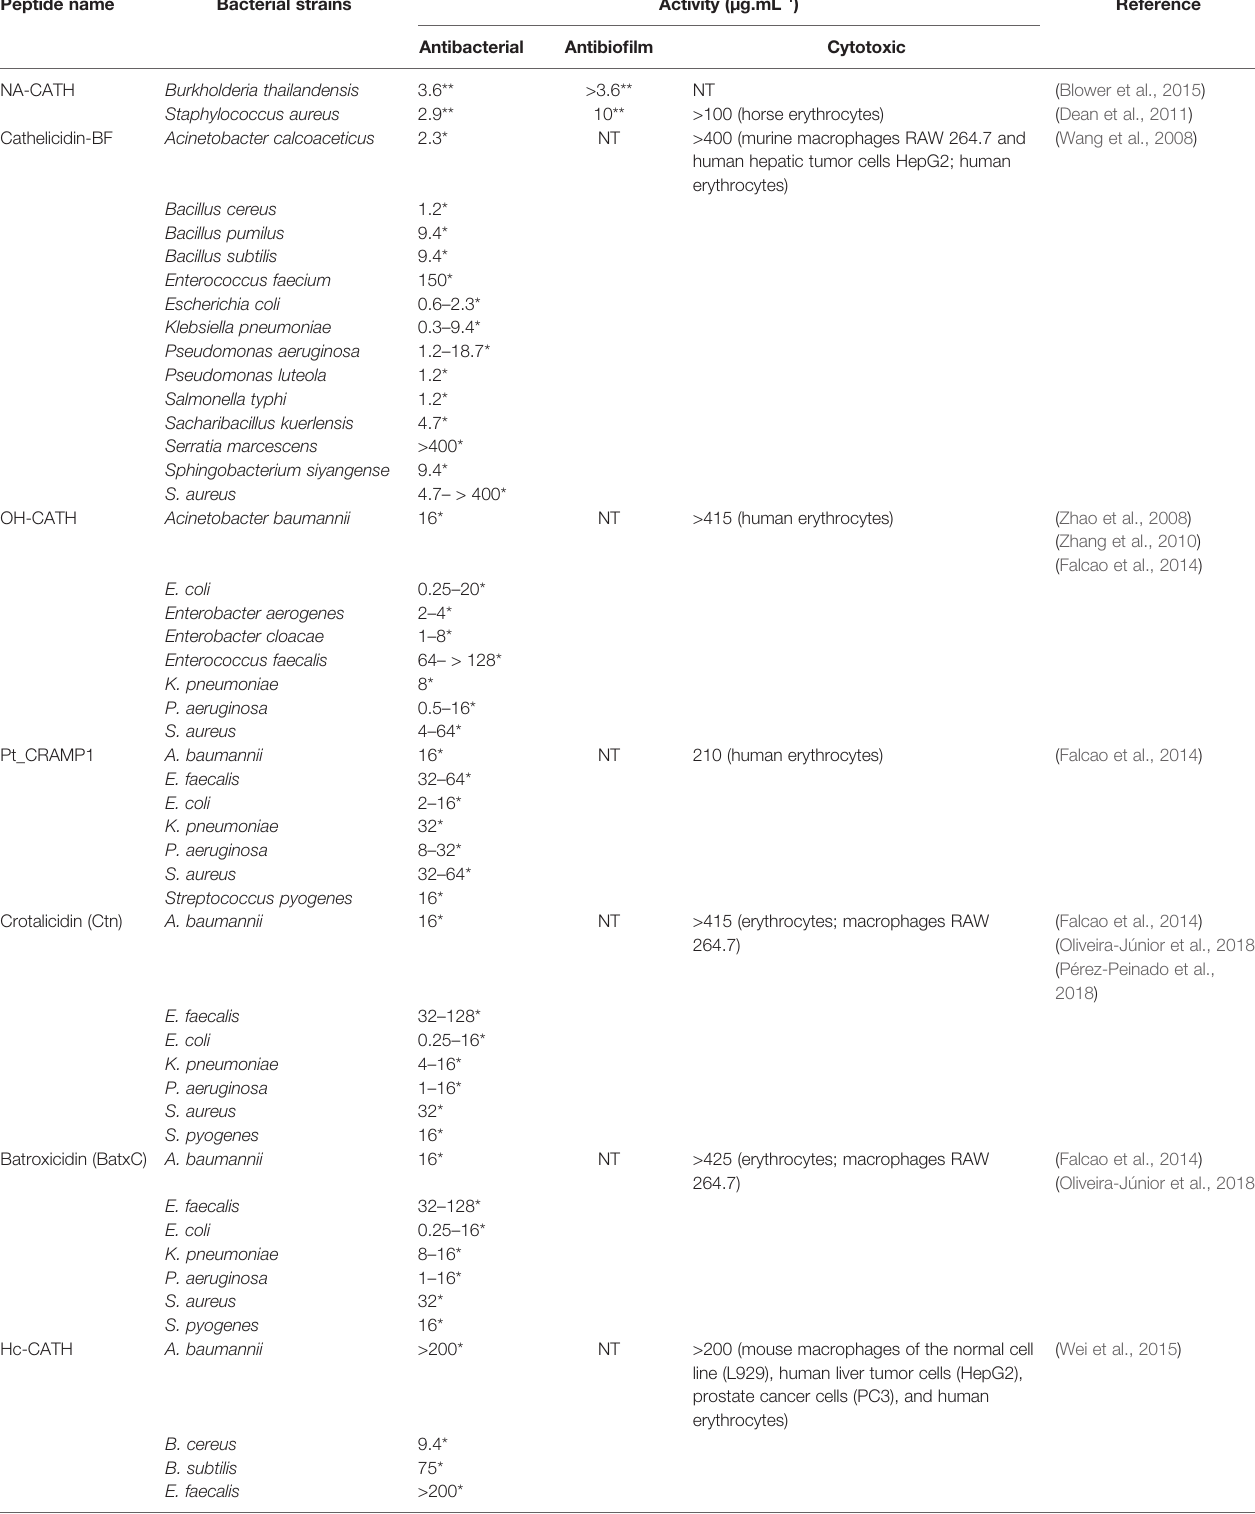
TABLE 2 | Antibacterial, antibio fi lm, and cytotoxic activity of snake venom cathelicidins against standard and clinical isolate bacterial strains, including multidrug- resistant Gram-positive and -negative bacteria. Peptide